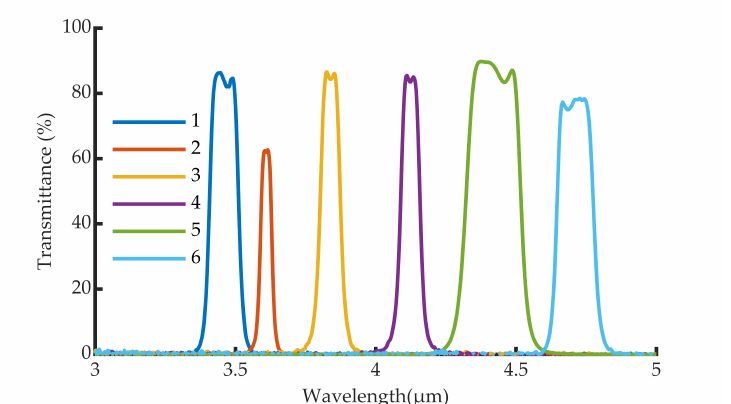
Figure 2. Spectral transmittance of the six interference filters used in the infrared camera. Each color represents a different optical